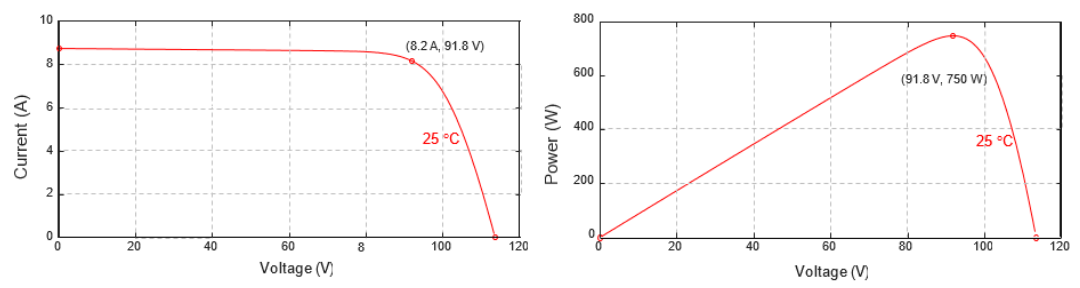
Figure 10. Curves I-V and P-V of one photovoltaic string of 3 series of modules of Isofoton ISF-250. Irradiance 1000 W/m 2